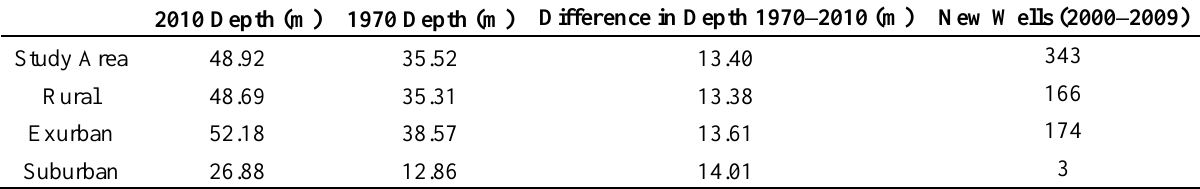
Table 5. Average depth to water, by housing-density class, in 1970 and 2010.